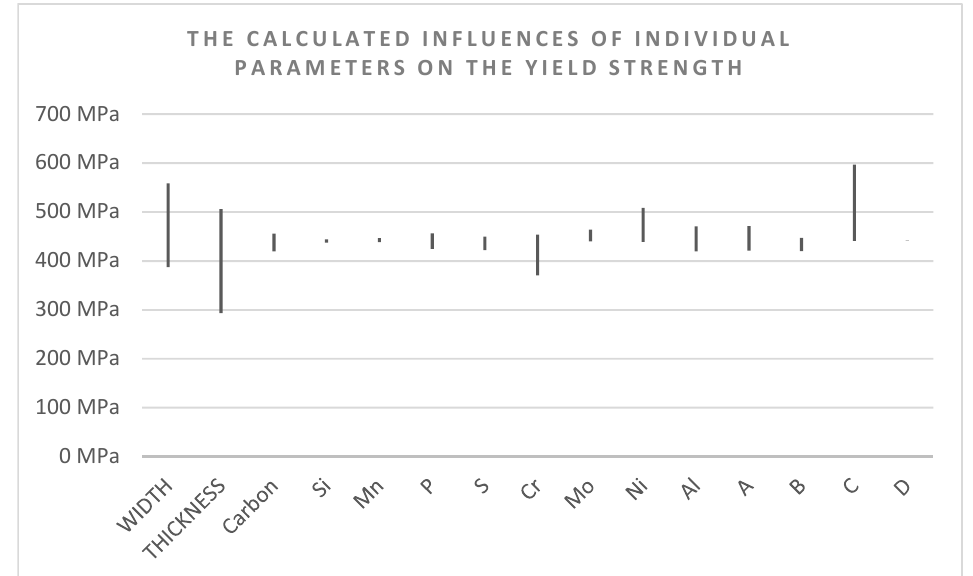
Figure 3. The calculated influences of individual parameters on the yield strength while separately changing individual parameter within the individual parameter range.